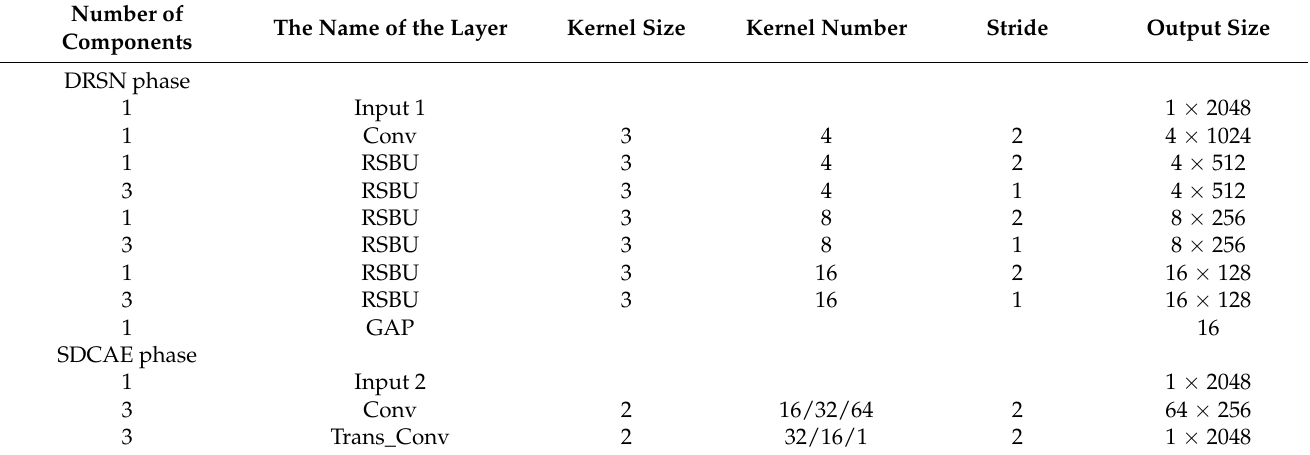
Table 2. Parameter settings for each layer of the adaptive feature extraction